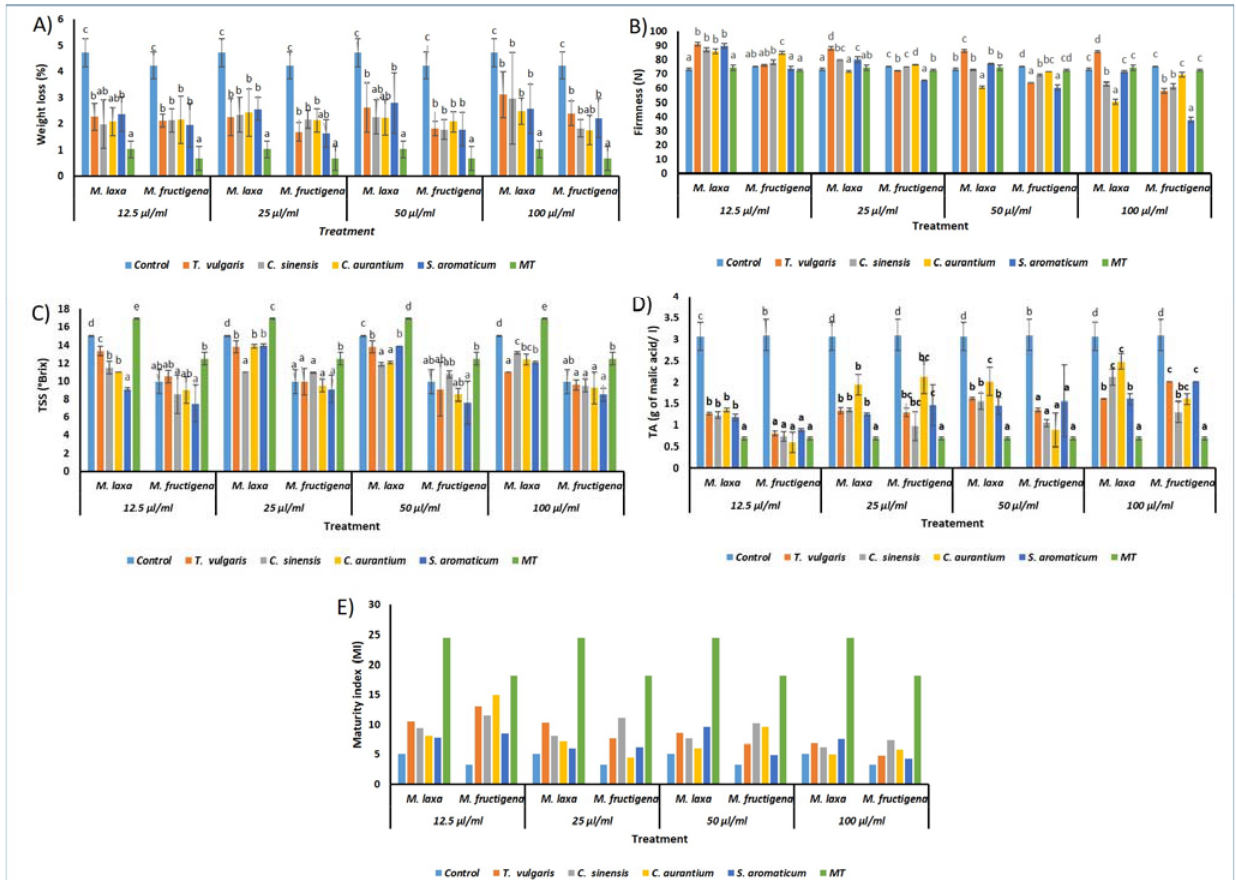
Figure 3. Effect of treatments on fruit quality parameters. ( A ): Weight loss, ( B ): Firmness, ( C ): TSS, ( D ): TA, and ( E ): Maturity index (MI). In each figure, treatments having the same letters are not significantly different according to Tukey’s test ( p < 0.05).